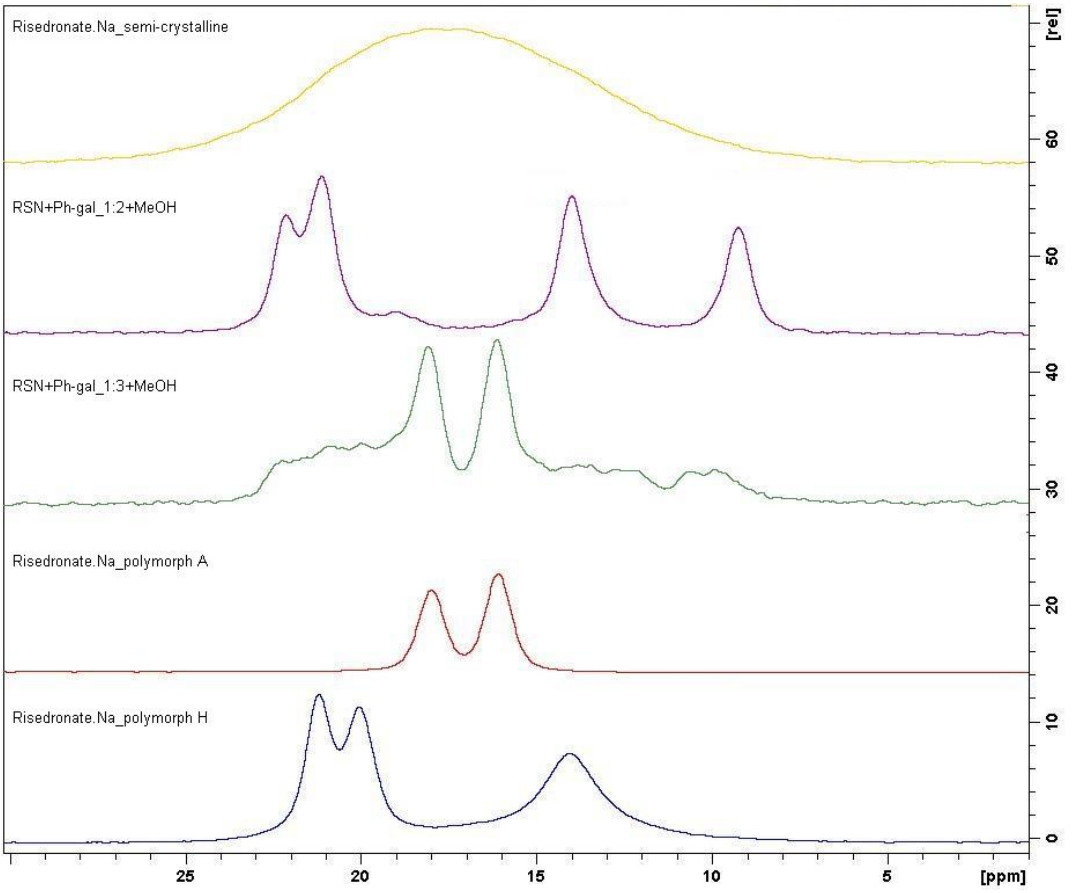
Figure 15. Comparison of 31 P CP/MAS NMR spectra of semi-crystalline risedronate monosodium salt (RSN), forms A and H and samples 6 and 7